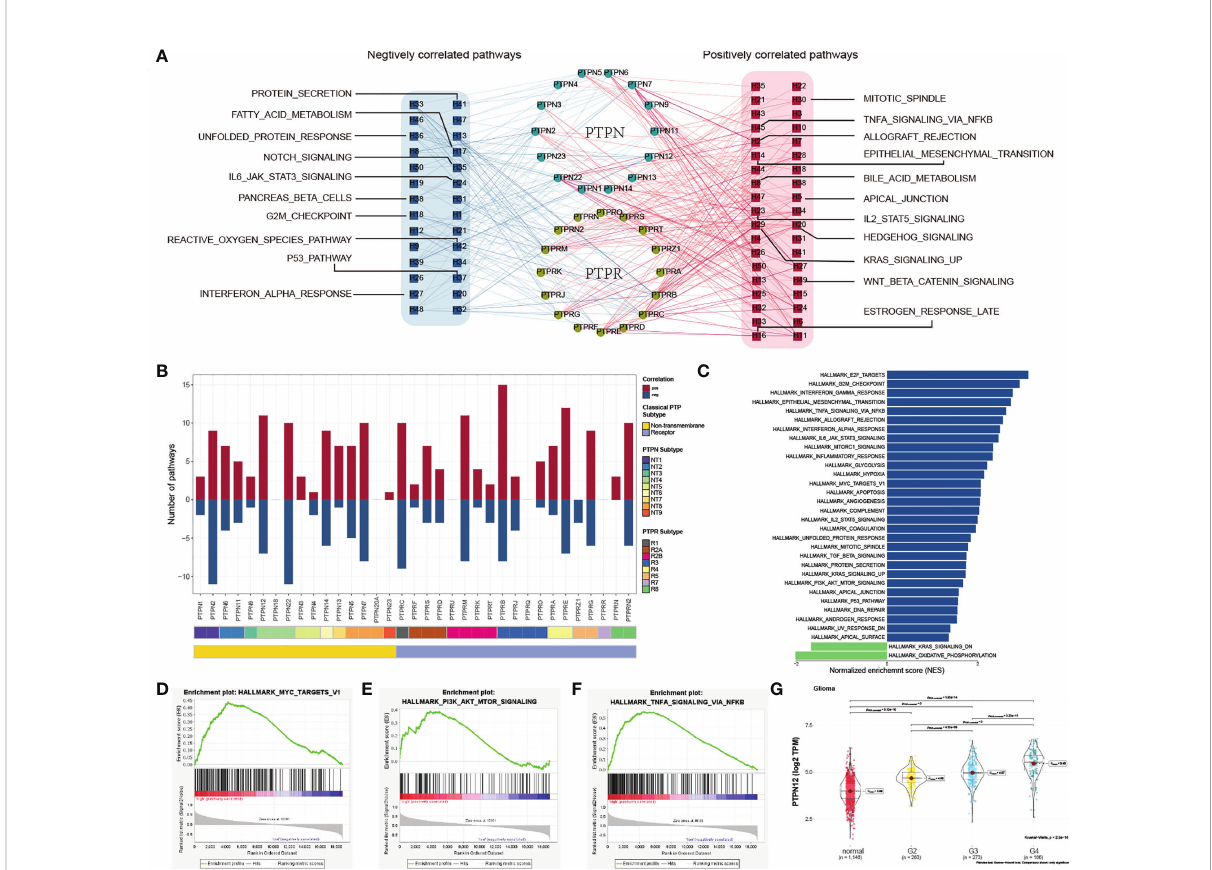
FIGURE 3 Functional analysis of classical PTPs in cancer-hallmark pathways. (A) Network of correlation between classical PTPs and cancer-hallmark pathways. (B) The number of pathways of involved PTPs. (C) Distribution of normalized enrichment scores for pathways using GSEA analyzing PTPN12 functions. (D – F) GSEA enrichment plot of the representative gene sets for PTPN12. (G) Relationship between the PTPN12 expression and clinical-grade in